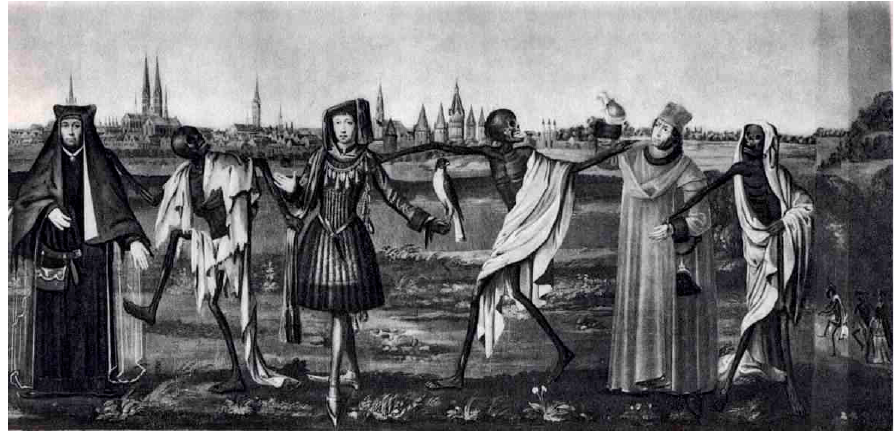
Figure 2. Detail of the Danse macabre (Totentanz) in the church St. Marien in Lübeck, Germany (Bernt Notke; ~1460; now destroyed). By analogy to this 15th century type of imagery, in the UMD family of decay pathways UPF1 represents Death (the skeleton in the picture) who leads the various types of UMD targets (representatives of any age and rank) to their final destiny.